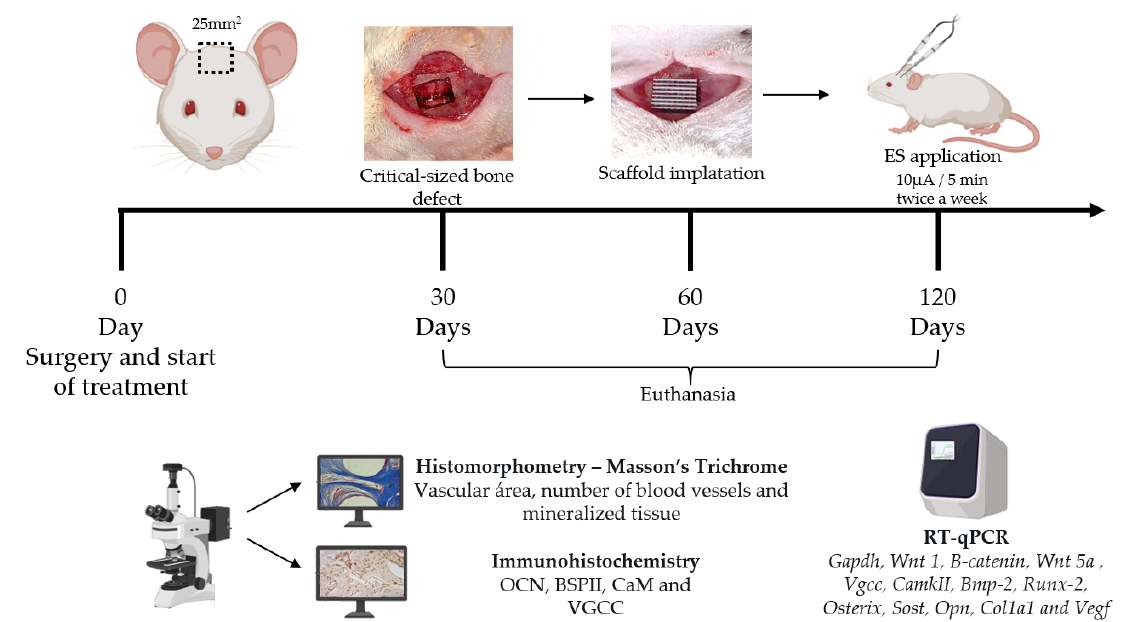
Figure 1. Scheme of the timeline of follow-up (surgery, treatments, euthanasia and sample harvesting) and experimental analysis.